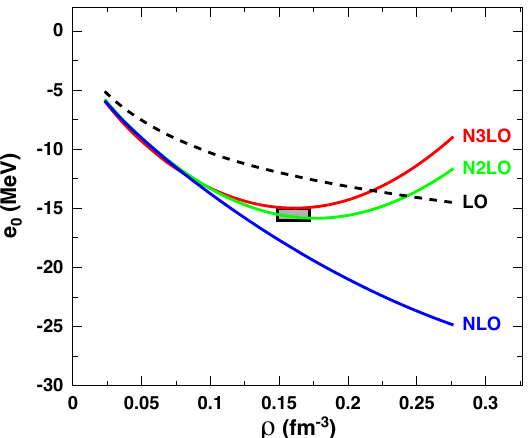
Figure 2. Energy per particle in symmetric nuclear matter as a function of density from leading to fourth order of chiral perturbation theory. The cutoff is fixed at 450 MeV. The shaded box marks the empirical saturation point. The EoS are the same as obtained in Ref.